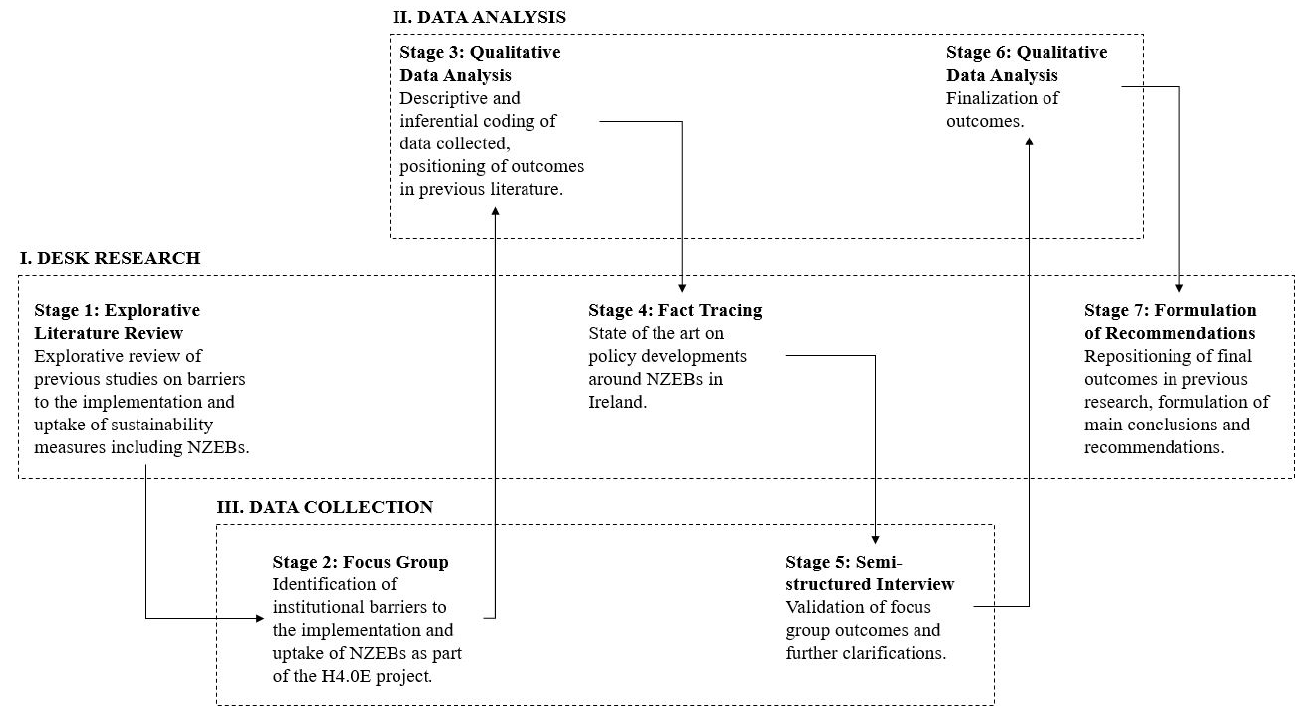
Figure 1. Iterative research process.